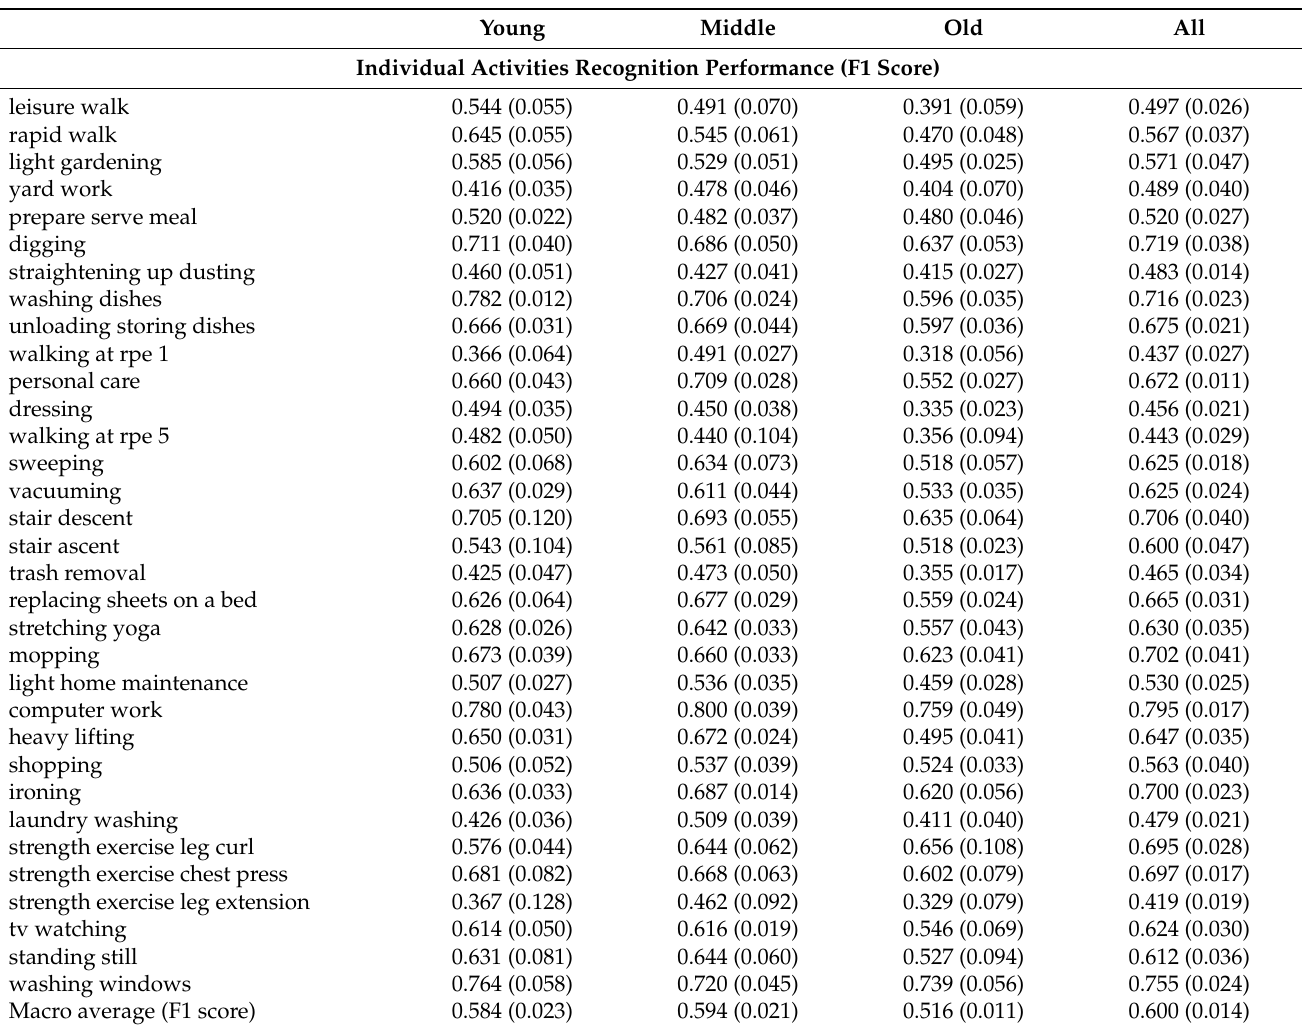
Table 3. Performance metrics of recognizing individual physical activities using XGBoost. Each value is the mean and standard deviation of the 5-fold nested cross